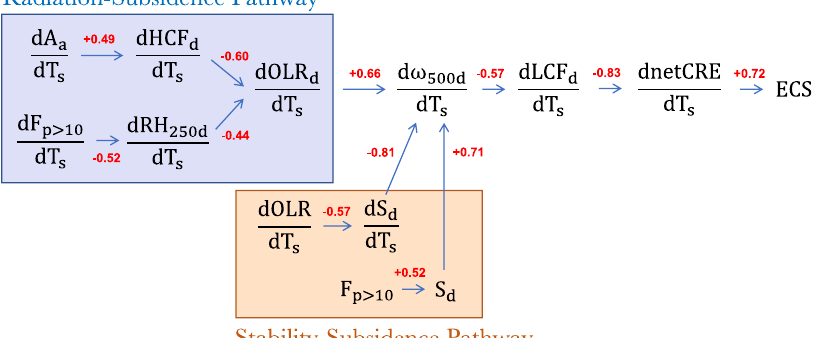
Fig. 9 | A summary of statistically signi fi cant correlations between various quantities comprising the Radiation-Subsidence and Stability-Subsidence Pathways. The correlations summarize the results shown in Figs. 2, 4, 6, and 7 among the CMIP6 multi-model ensemble. The Radiation-Subsidence Pathway is